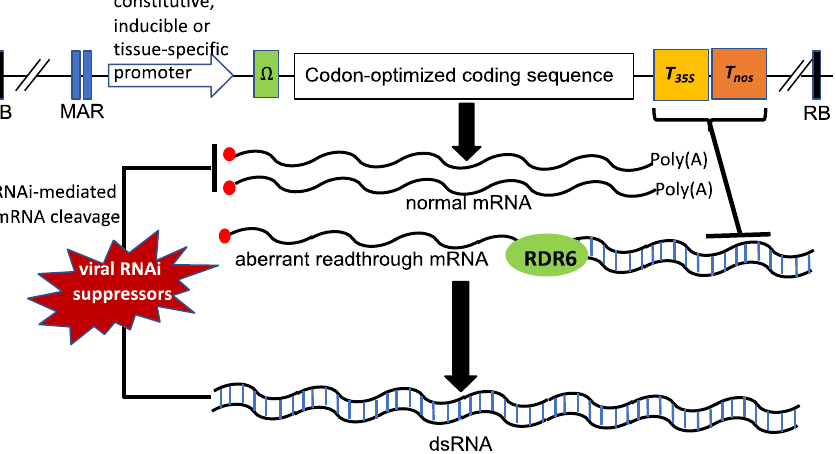
Figure 2. Major elements of the expression constructs for maximizing the production of recombinant proteins in plants through the enhancement of transcription and translation and the suppression of transcriptional and posttranscriptional gene silencing.